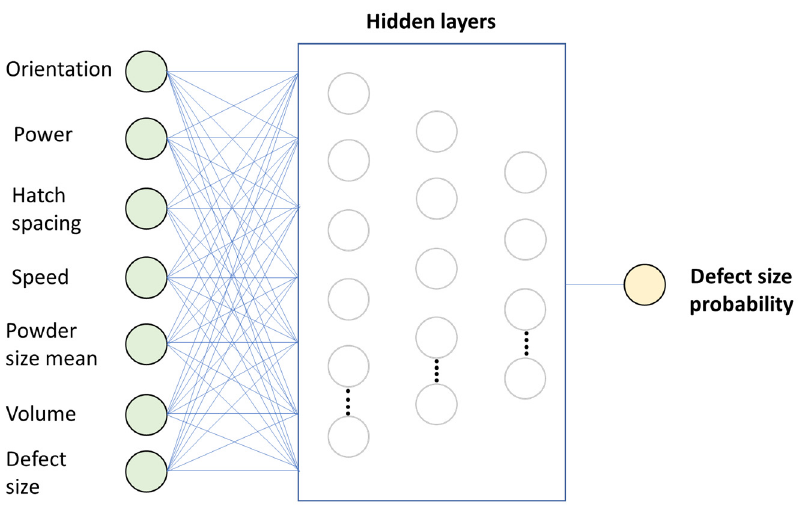
Figure 2. ML algorithm which provides in output the probability associated with a defect with size (cid:3493)𝑎 (cid:3030) (Probability ML). a c (Probability